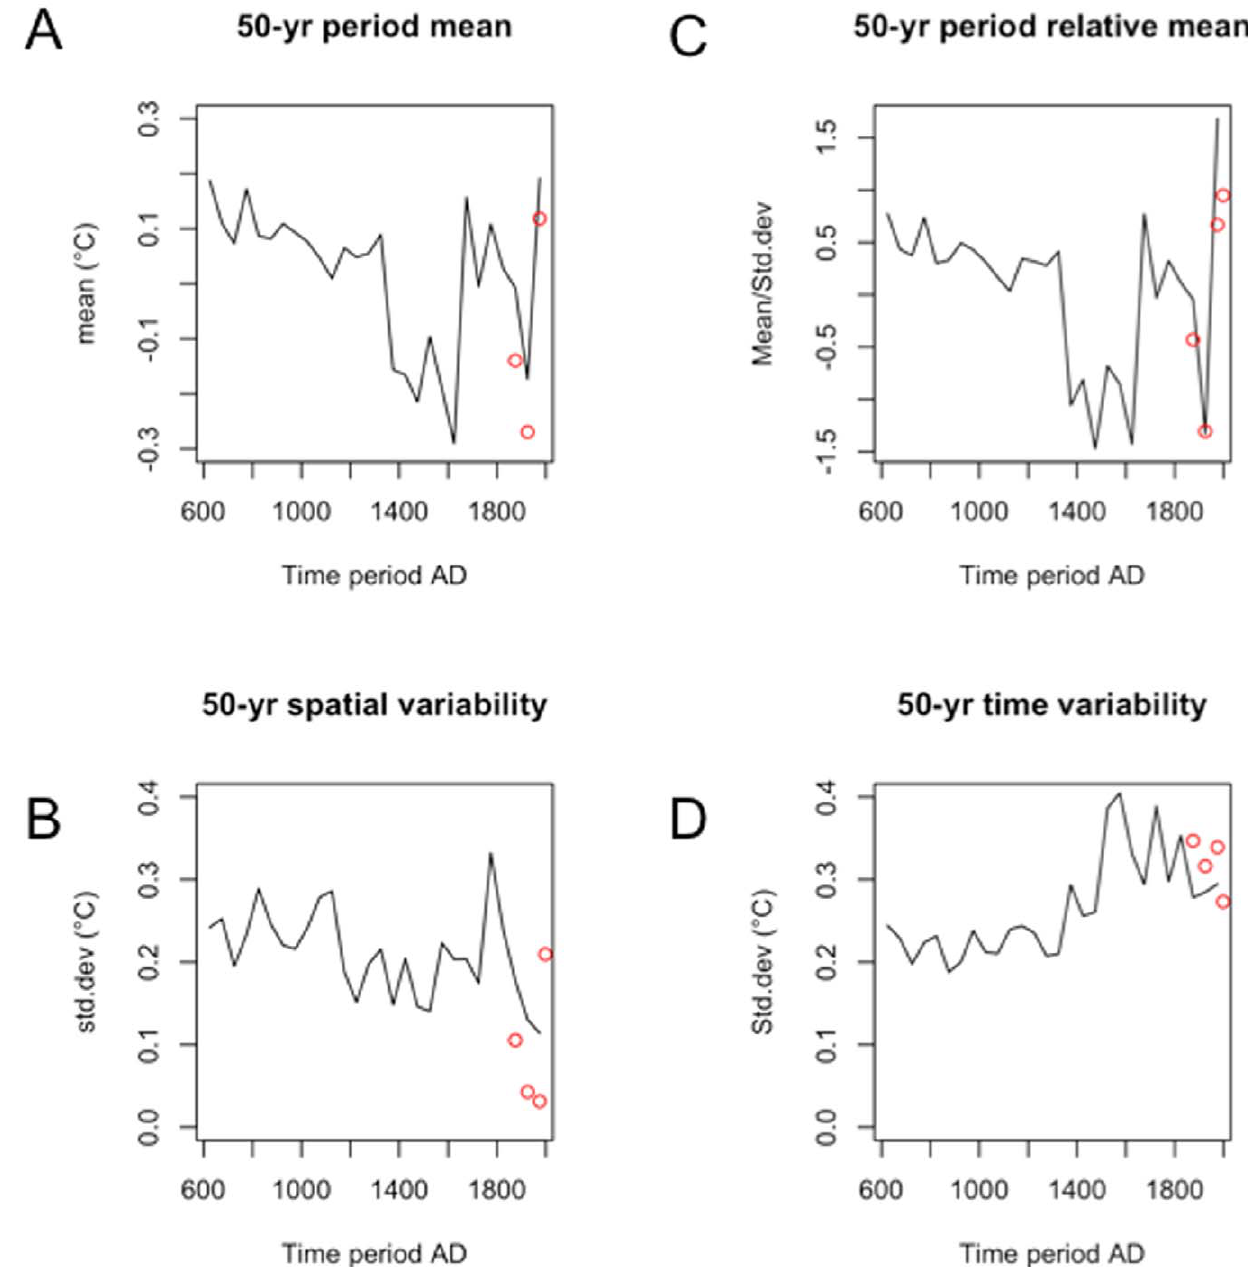
Figure 10. Comparison of means and variances. (A) Sliding spatial mean and (B) variance calculated on 50-yr maps (we have first calculated 50-yr maps and then averages and variances of these maps). Panel (C) represents the ratio of curves (A) and (B). Panel D represents the standard deviation of the European mean temperature by 50-years intervals. Black lines represent the reconstructions and red circles represent the observations.